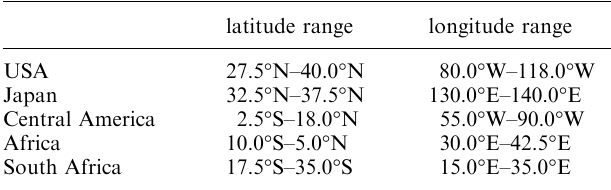
Table 3. Latitudinal and longitudinal regions used to bin rain gauge and cloud imagery data latitude range